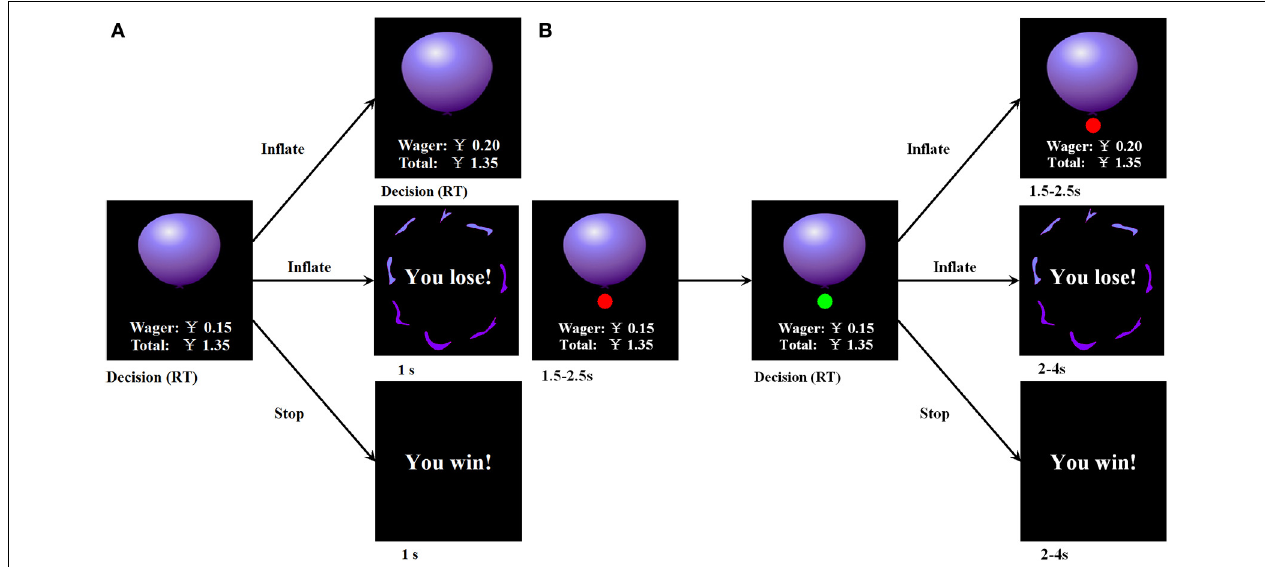
FIGURE 1 | Overview of (A) behavioral and (B) fMRI-adapted versions of the BART procedure and